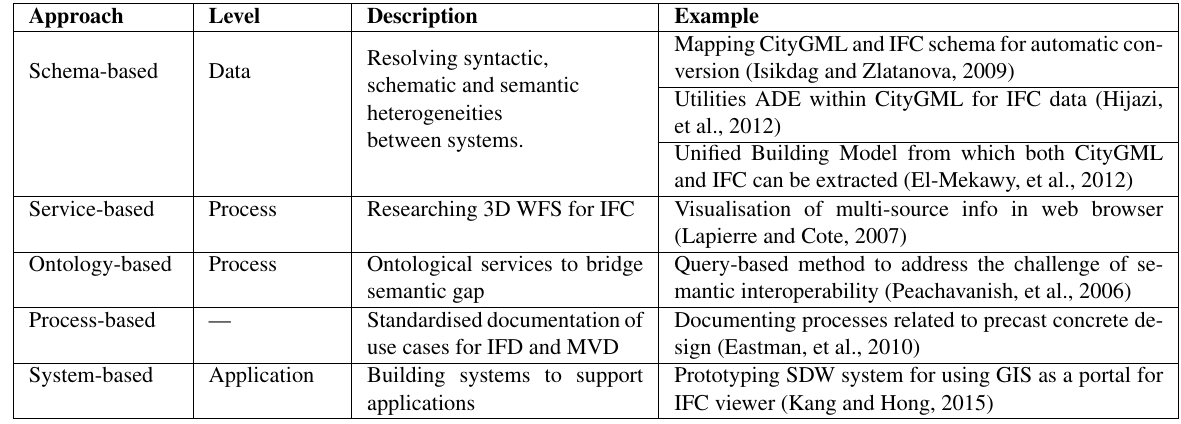
Table 1. Five research approaches and three levels of BIM/GIS integration (Kang and Hong, 2015; Amirebrahimi, et al., 2015) The Crossrail technical information team are trialling the excha- nge of BIM information from a CAD platform to a GIS